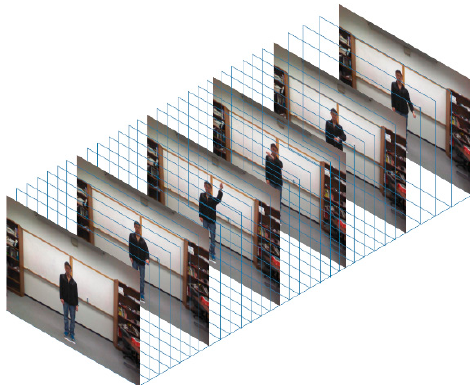
Figure 1. Example video volume as input to the 3D convolution neural network.